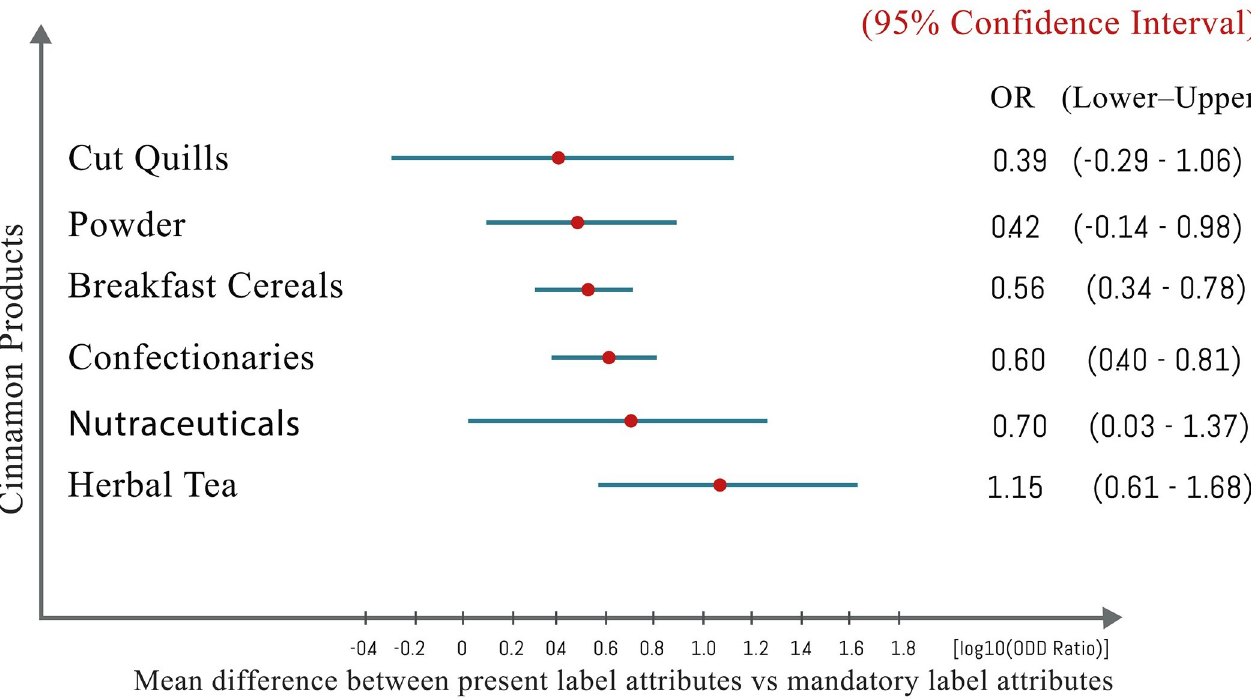
Fig 6. Mean difference of the present label attributes with labelling requirements of FAO (Codex Alimentarius). The no. of observations in each category was cinnamon quills (48), cinnamon powder (46), breakfast cereals (41), Confectionery and bakery (56), Nutraceuticals (31), and cinnamon tea (54). Mean label attribute sizes shown with 95% confidence interval.